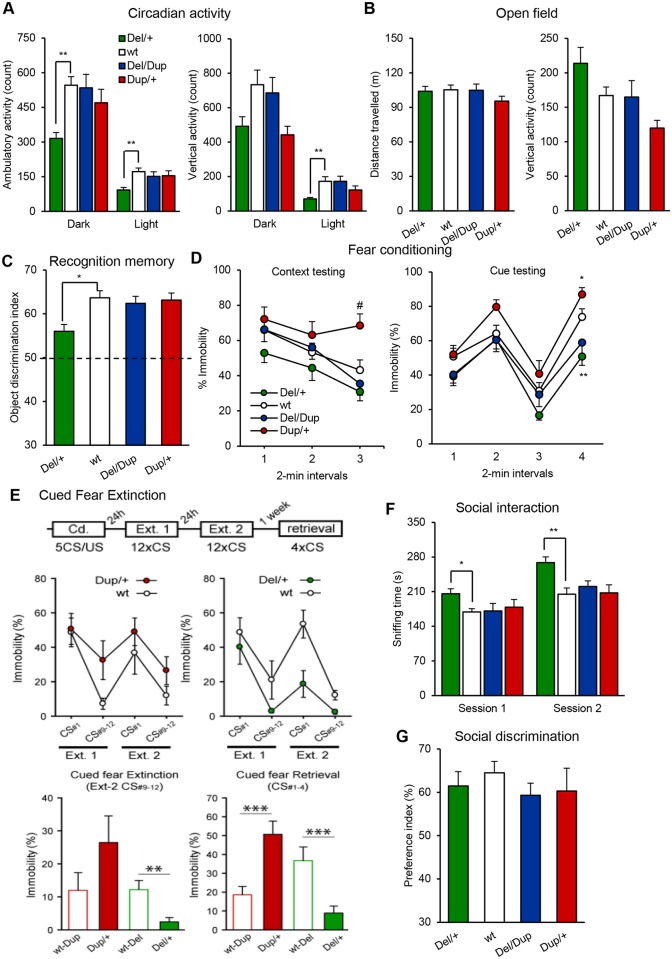
Behavioral characterization of Del-Dup cohorts.(A) Circadian activity test. Graphs plot the spontaneous ambulatory activity (count) and the vertical activity/rears (count) during dark and light phases. Del/+ mice showed reduced ambulatory activity during the dark phase (F(3,46) = 5.791, P = 0.002; Del/+ vs wt: P = 0.002) and the light phase (F(3,46) = 4.260, P = 0.010; Del/+ vs wt: P = 0.006) as well as reduced rearing behavior during the light phase (H(3, 46) = 12.861, P = 0.005; Del/+ vs wt: P = 0.002) (B) Open field test. Distance travelled (m), and vertical activity/rears (count) over 30 min of testing. (C) Novel object recognition test. Discrimination index was calculated as the ratio of time spent exploring the novel object vs the total time for object sniffing in the choice trial after a 3 h retention delay. The dashed line denotes a chance level of 50% (F(3,43) = 3.081, P = 0.037; Del/+ vs wt: P = 0.040). (D) Fear conditioning test. Plots represent the percentage of time spent freezing during test sessions. The 6-min context session was run 24 h after conditioning. The 8-min cue session was performed 5 h after the context session. A sequence of 2-min without cue and 2 min with light/auditory conditioning stimulus was repeated twice. (E) Cued fear extinction. Independent group of Del /+ and Dup/+ mutant mice with their respective wt control littermates were evaluated for cued fear extinction. Immobility was increased in Dup/+ compared to control while it was decreased in the Del/+ carriers during the two test periods for extinction (Ext1 (24 h) and Ext2 (48 h)). After one week the cued fear retrieval was observed in the Dup/+ mice compared to their wt littermates whereas it was absent in the Del/+ compared to their control. (F-G) Three-chamber sociability test. (F) Exploration time (s) of the first congener in the social interest session (session 1) and total exploration time of familiar and novel congeners in the social discrimination session (session 2). No delay was used between the two sessions. (G) Discrimination index was calculated as the ratio of time spent exploring the novel congener vs the familiar one. Data are represented as the mean ± s.e.m. Cohort used included 18 Del/+, 24 wt, 11 Del/Dup, and 11 Dup/+ animals. Post hoc Tukey's and Mann Whitney U tests were performed following significant results in one-way ANOVA or Kruskal Wallis analysis, respectively. *P < 0.05 vs wt, **P < 0.01 vs wt, ***P < 0.001 vs wt, #
P < 0.05 vs all other groups.